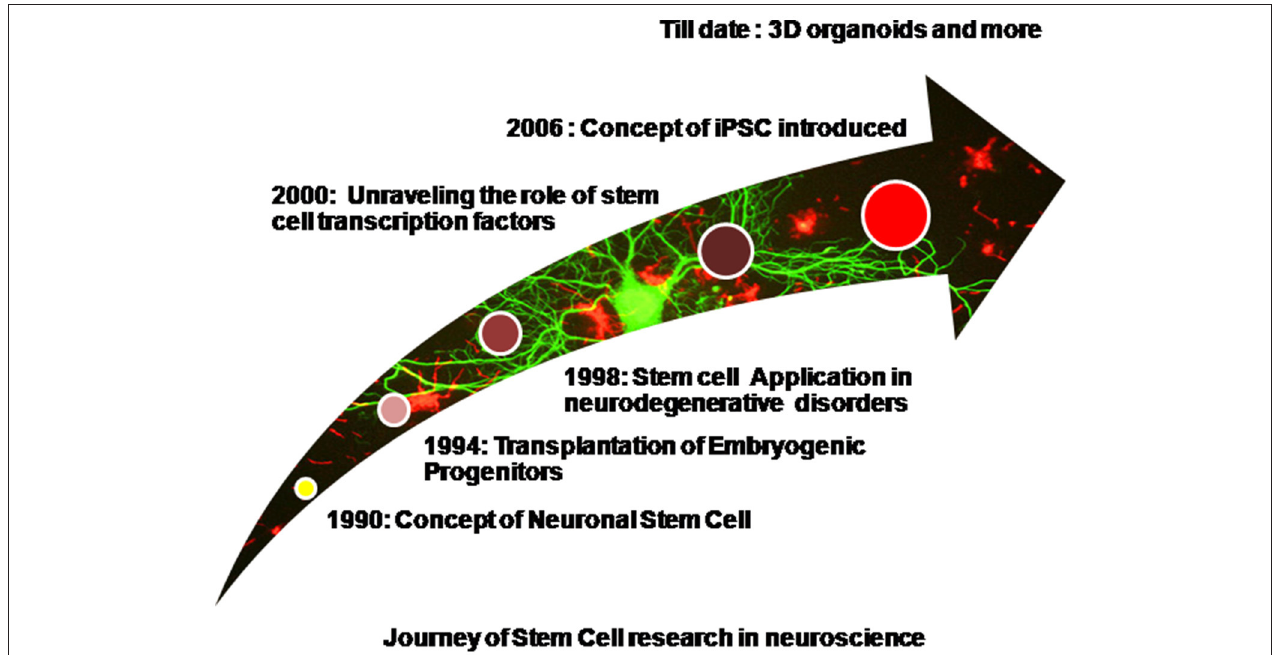
FIGURE 1 | Diagrammatic representation of progress made in the field of stem cell research in context with